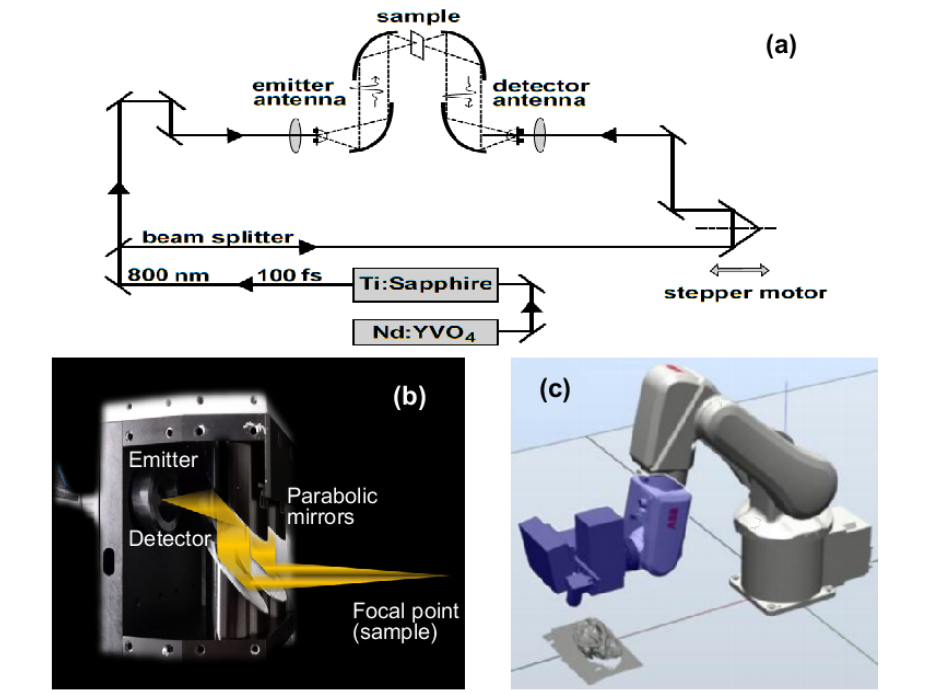
Figure 1. ( a ) Schematic of a free-space THz time-domain spectrometer in transmission geometry. ( b ) Schematic representation of a reflection geometry of a terahertz system. ( c ) Render of a THz reflection setup mounted on a robotic arm while doing a scan of an arbitrarily shaped object. Panels ( b , c ). Adapted with permission